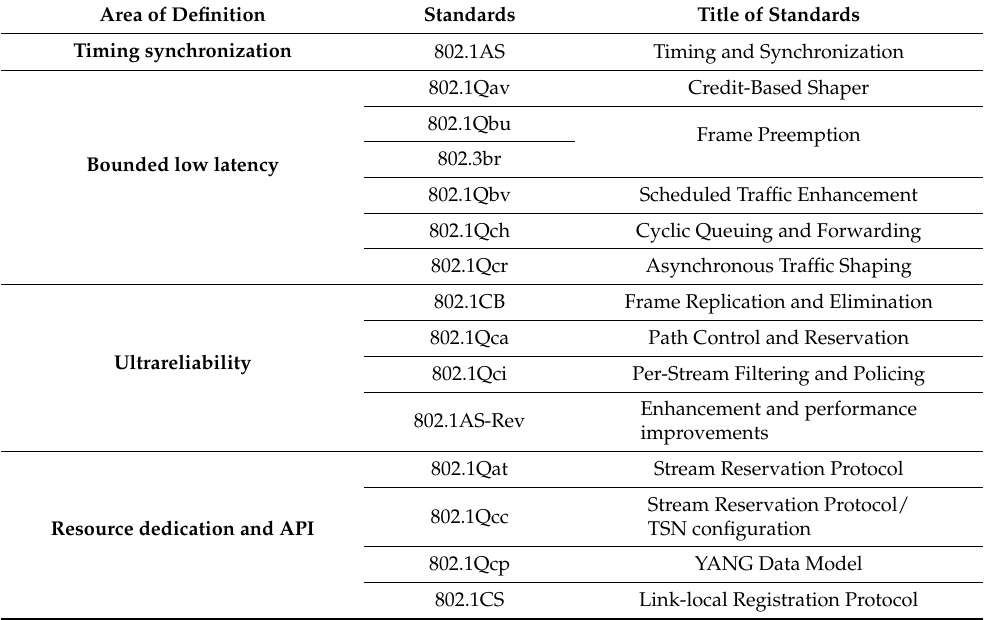
Table 1. A short list of IEEE Time-Sensitive Networking (TSN) Standards. API—application pro- gramming